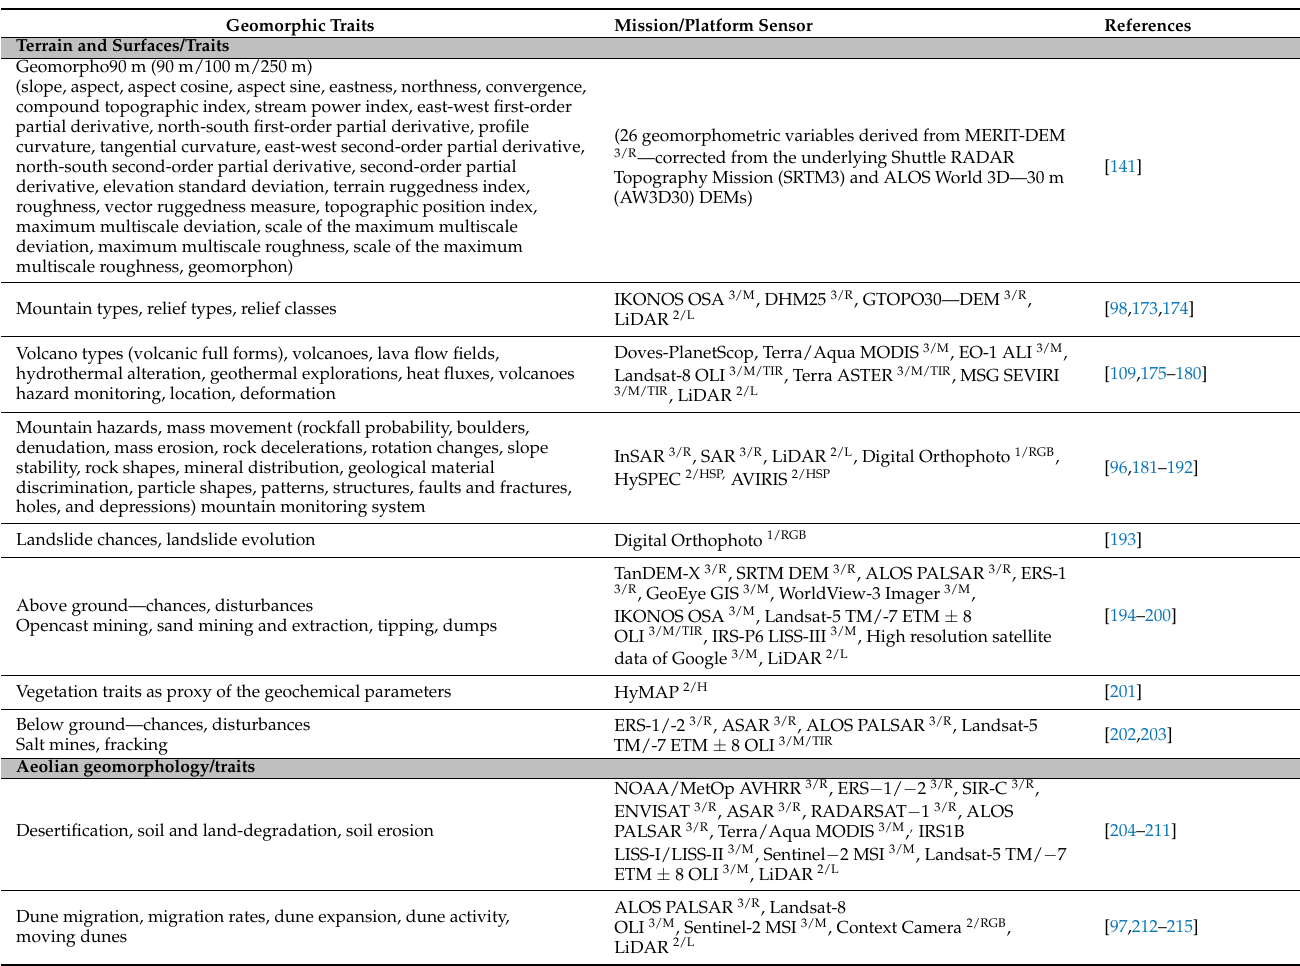
Table A1. Remote sensing (RS)-aided examples derived in monitoring the characteristics of ge- omorphodiversity (geomorphic traits, diversity, structural, taxonomic, and functional diversity characteristics), shifts, and disturbances (modified after Lausch et al.